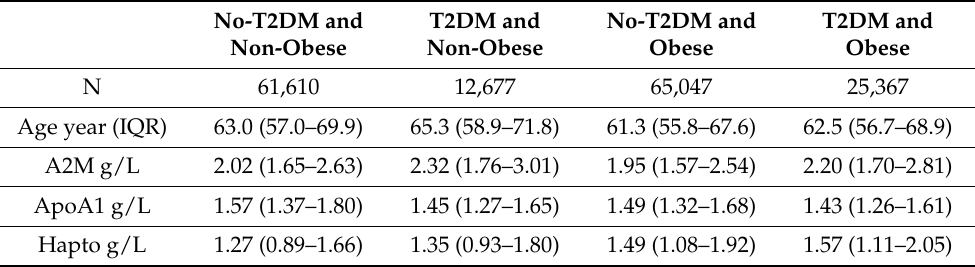
Table 3. Characteristics and median protein levels in women ≥ 50 years of age according to T2DM and obese